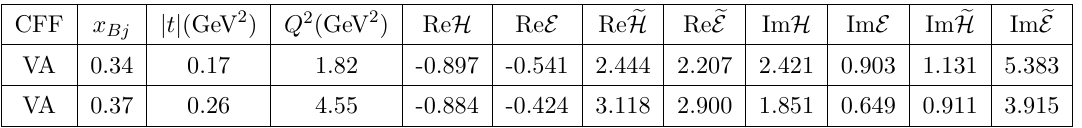
Table 1 . CFFs used for numerical comparison, see